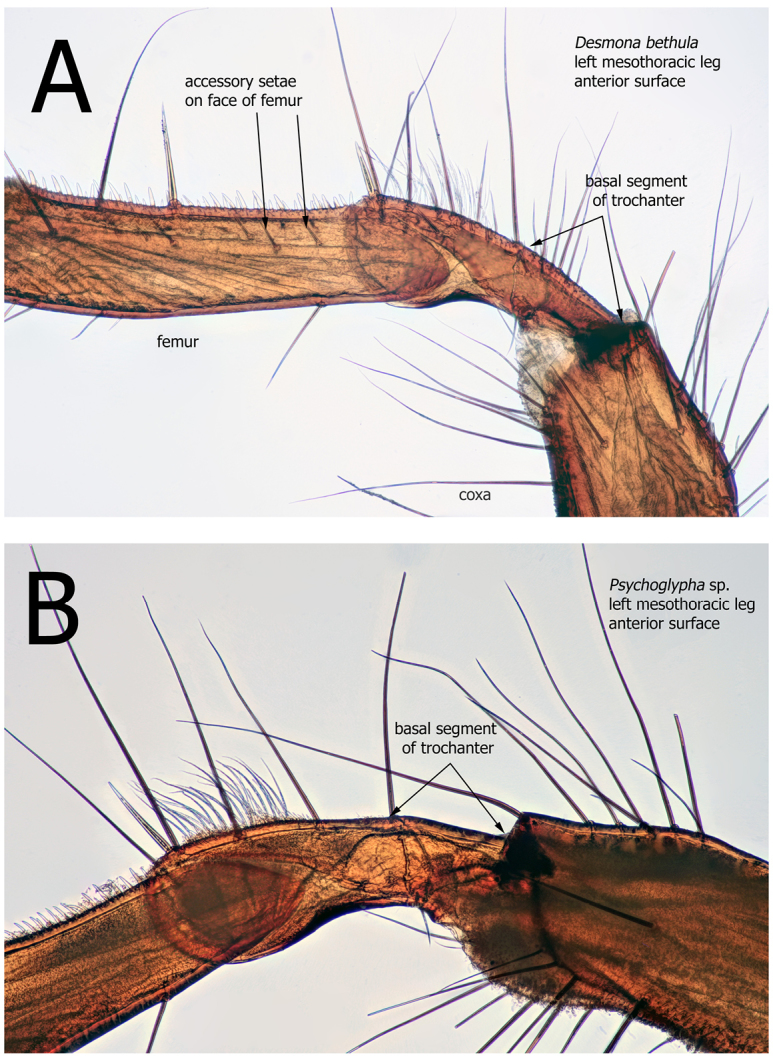
Mesothoracic trochanter. Larvae (A, B) ADesmonabethula, left side, anterior surface BPsychoglypha species, left side, anterior surface.